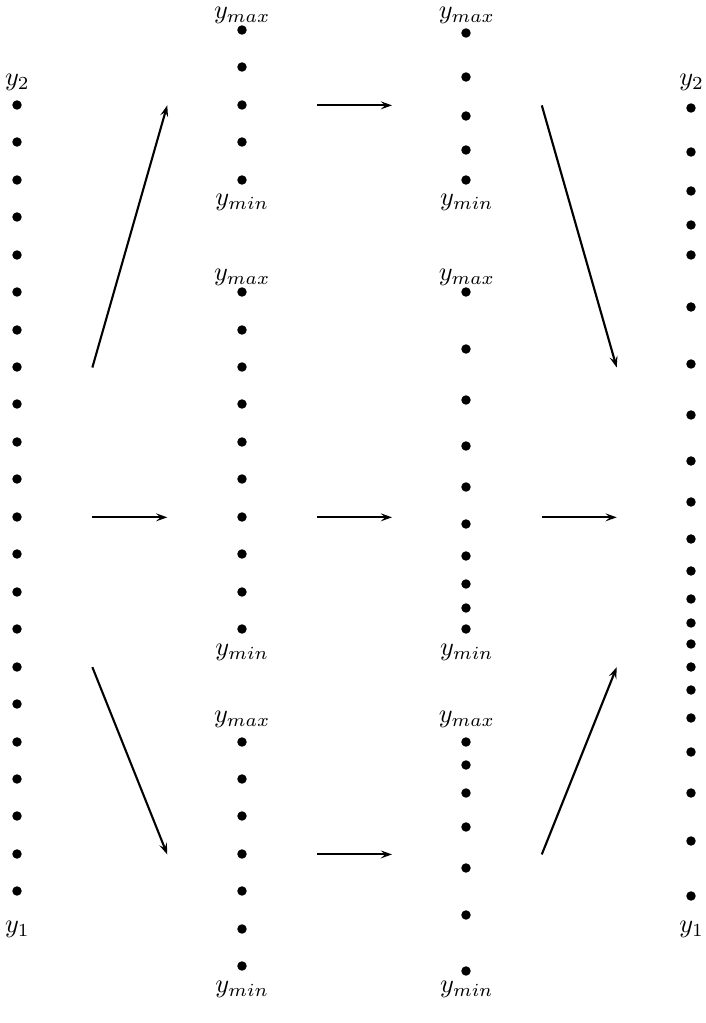
Figure 2. The schematic representation of the refinement